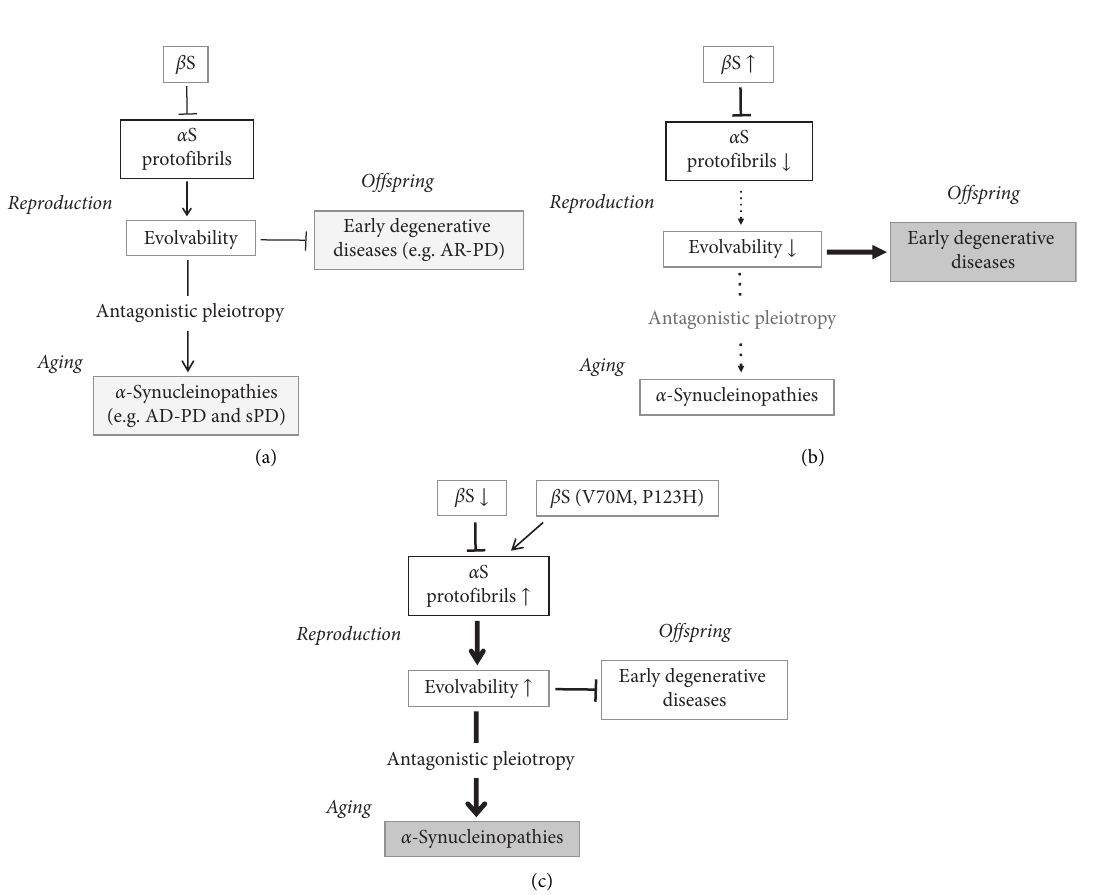
Figure 3: Schematic of the buffering effect of β - on α S evolvability (a) α S protofibrils might be involved in resistance against multiple stresses in parental brains. By virtue of information carried by transgenerational transmission of α S protofibrils in reproduction, offspring can cope with forthcoming stresses in the brain, otherwise leading to early degenerative diseases, including AR-PD. On the other hand, α -synu- cleinopathies, such as AD-PD and sPD, are later manifested through antagonistic pleiotropy mechanism in aging. Thus, α S evolvability acts as an inheritance of acquired characteristics that are evolutionally beneficial. β S might interact with α S and inhibit the aggregation of α S. As a result, β S might mitigate the neurotoxicity of α S and negatively regulate α S evolvability. (b) If expression of β S is too high, the aggregation of α S is inhibited and α S evolvability would be decreased. Consequently, the brain in offspring cannot obtain stress information enough to escape from developmental diseases. Instead, manifestation of neurodegenerative diseases may be less frequent in aging. (c) If expression of β S is too low, the aggregation of α S may be stimulated, and α S evolvability would be increased. As a result, neurodevelopmental diseases will be suppressed, whereas neurodegenerative diseases may later be manifested through the antagonistic pleiotropy mechanism in